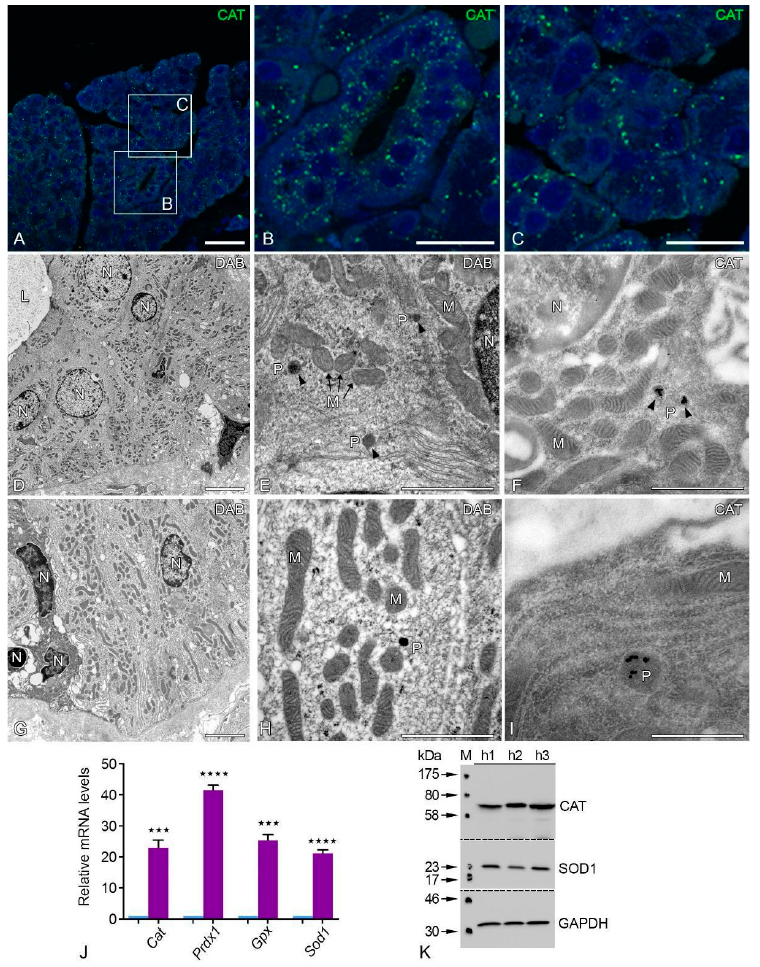
Figure 5. Ultrastructural catalase activity and protein localization in various cell types of the human parotid gland. IF staining of peroxisomal marker protein catalase in the human parotid gland ( A ) and the corresponding higher magnification of human acini ( B ) and striated ducts ( C ). Catalase activity is stained cytochemically using the modified alkaline DAB technique ( D – I ). Lower magnification view of an acinar region of the human parotid gland ( D ). Respective higher magnification view of human acinar cell with a peroxisome adjacent to several mitochondria I. Similarly, lower magnification view of human parotid gland striated duct epithelial cells ( G ). Respective higher magnification view of a striated duct cell with a peroxisome adjacent to several mitochondria ( H ). The catalase protein was located using electron microscopy, immunocytochemistry, and the protein A-gold method after embedding slices of human parotid glands on LR white ( F , I ). View of an area in a human acinar cell under higher magnification that contains peroxisomes and mitochondria ( E , F ). Similarly, a higher magnification view of striated ducts containing peroxisomes ( H , I ). Arrowheads depict peroxisomes; N: nucleus; M: mitochondria; P: peroxisome, L: lumen. Bars represent: 100 µ m ( A ); 50 µ m ( B , C ); 10 µ m ( D , G ); 5 µ m ( E , F ); 0.25 µ m ( H ); 0.5 µ m ( I ). qRT-PCR analyses for mRNAs encoding peroxisomal antioxidative enzymes in human parotid tissues (violet bars) compared to Gapdh (blue bars) as a housekeeping gene ( J ). For the following mRNAs the respective p -values are Cat *** p < 0.0009, Prdx1 **** p < 0.0001, Gpx *** p < 0.0002, Sod1 **** p < 0.0001. Western blot analysis for CAT and SOD1expression in human parotid gland tissues ( K ). GAPDH was used as a loading